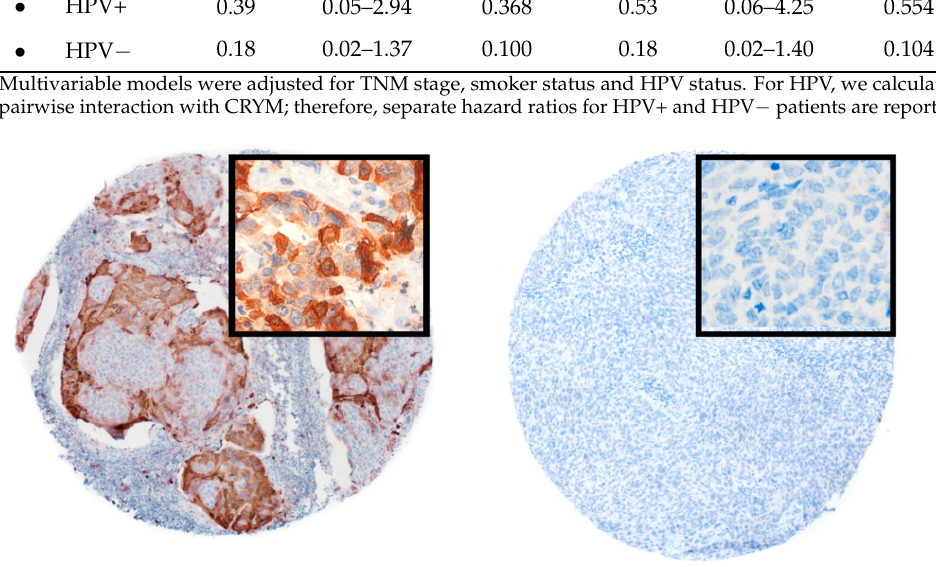
Figure 2. Representative images of immunohistochemical staining of tissue microarrays for CRYM. Positive cytoplasmatic staining ( n = 15) on the left side and negative staining ( n = 103) on the right side. Low-power field, 40 × ; high-power field (insets), 200 × .